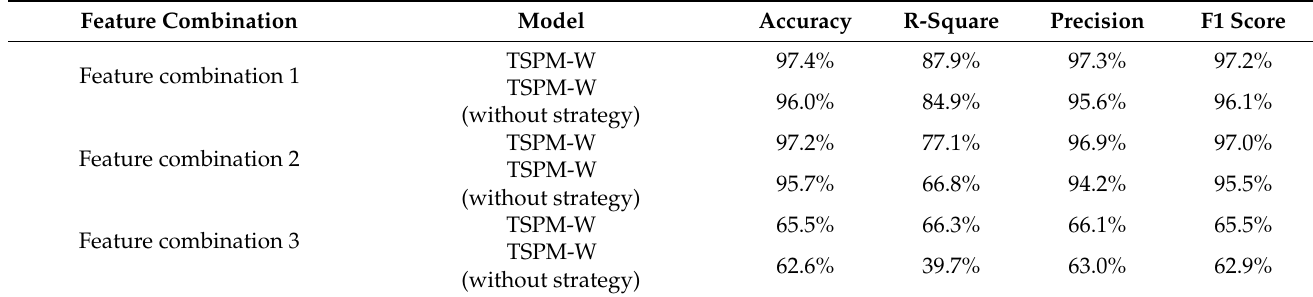
Table 5. Strategy features affect the results of comparative